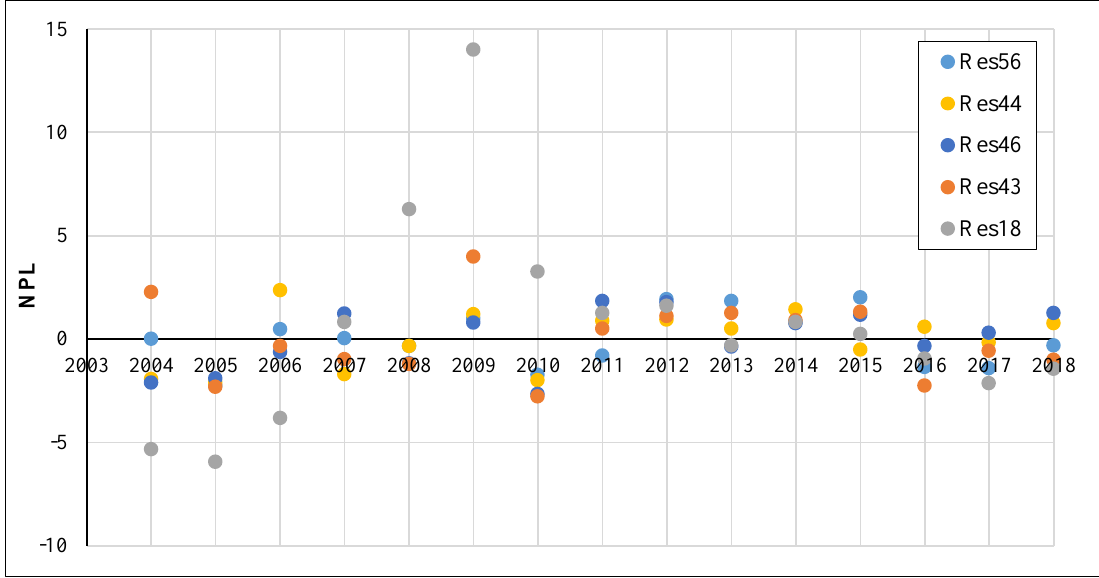
Figure 3. Best fit model’s residuals.